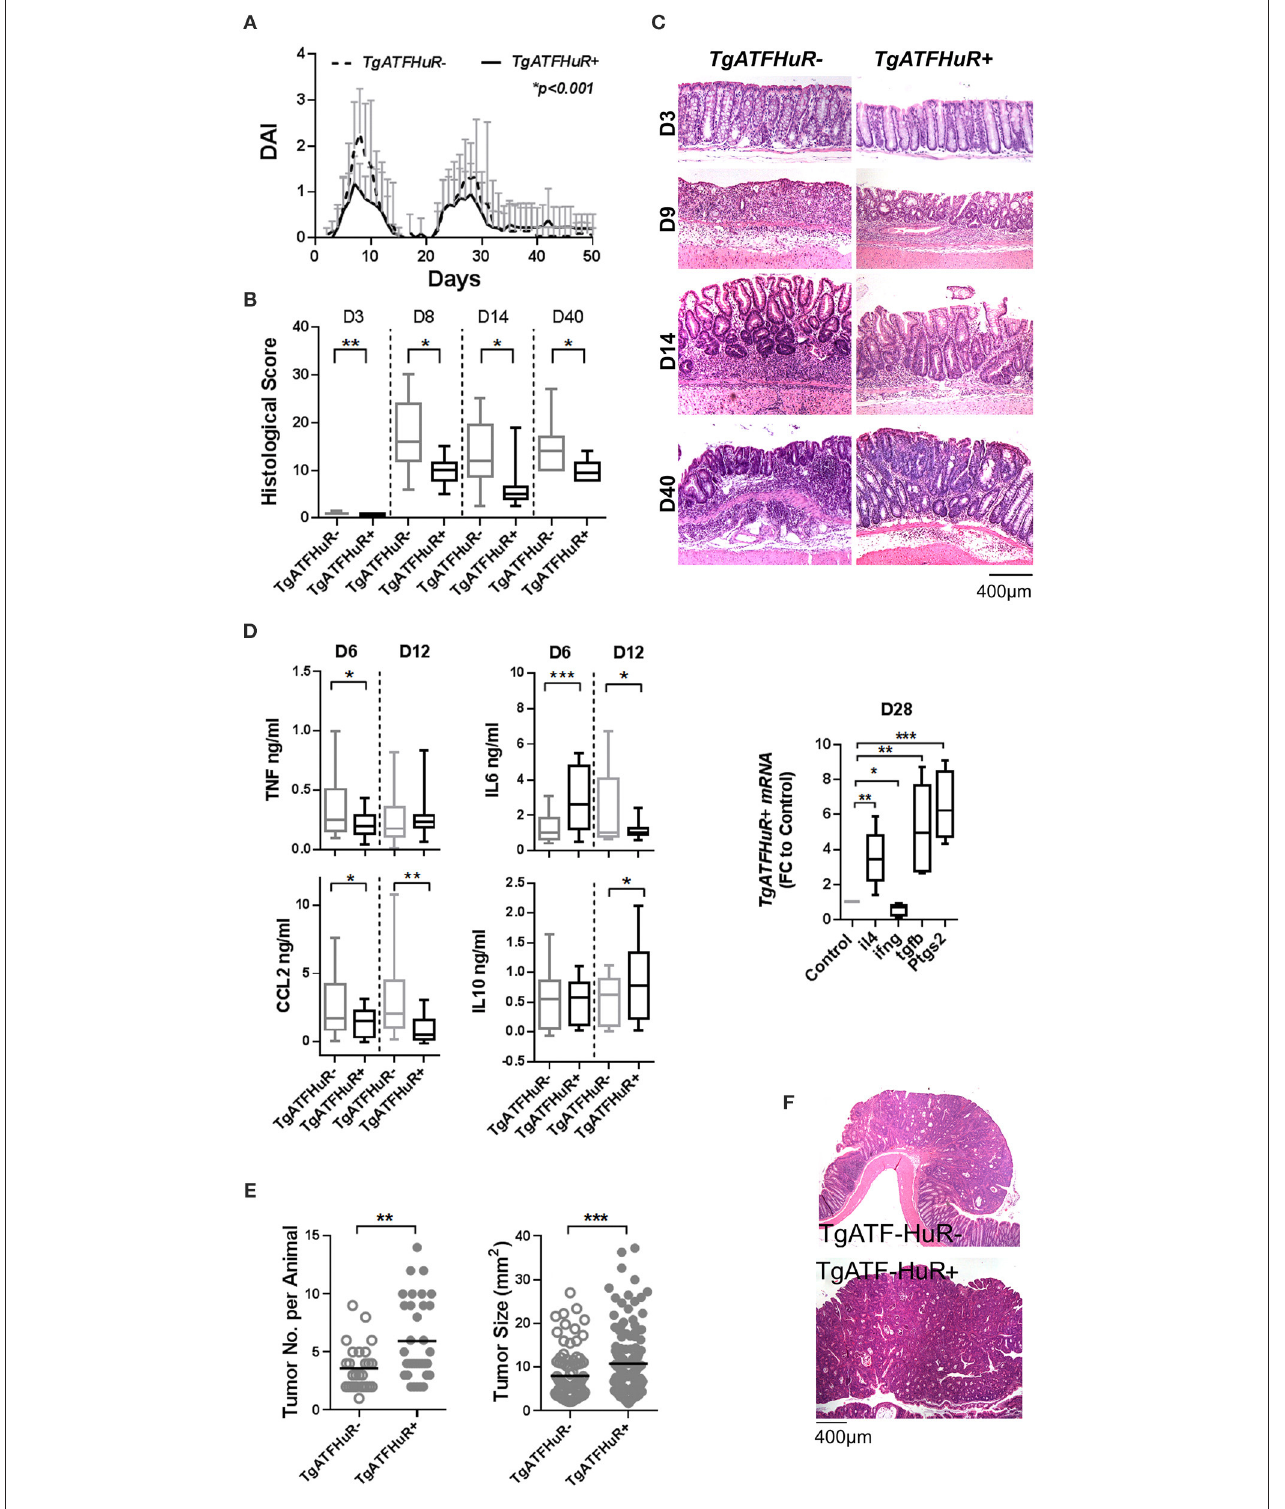
FIGURE 5 | The combinatorial elevation of HuR attenuates chemically-induced colitis but augments CAC. (A) Macroscopic Disease Activity Index (DAI) during the 2 rounds of DSS administration (Days 0 and 20) in TgATFHuR − and TgATFHuR + mice. Line graphs depict mean values ( ± SD). n = 20–30/group.